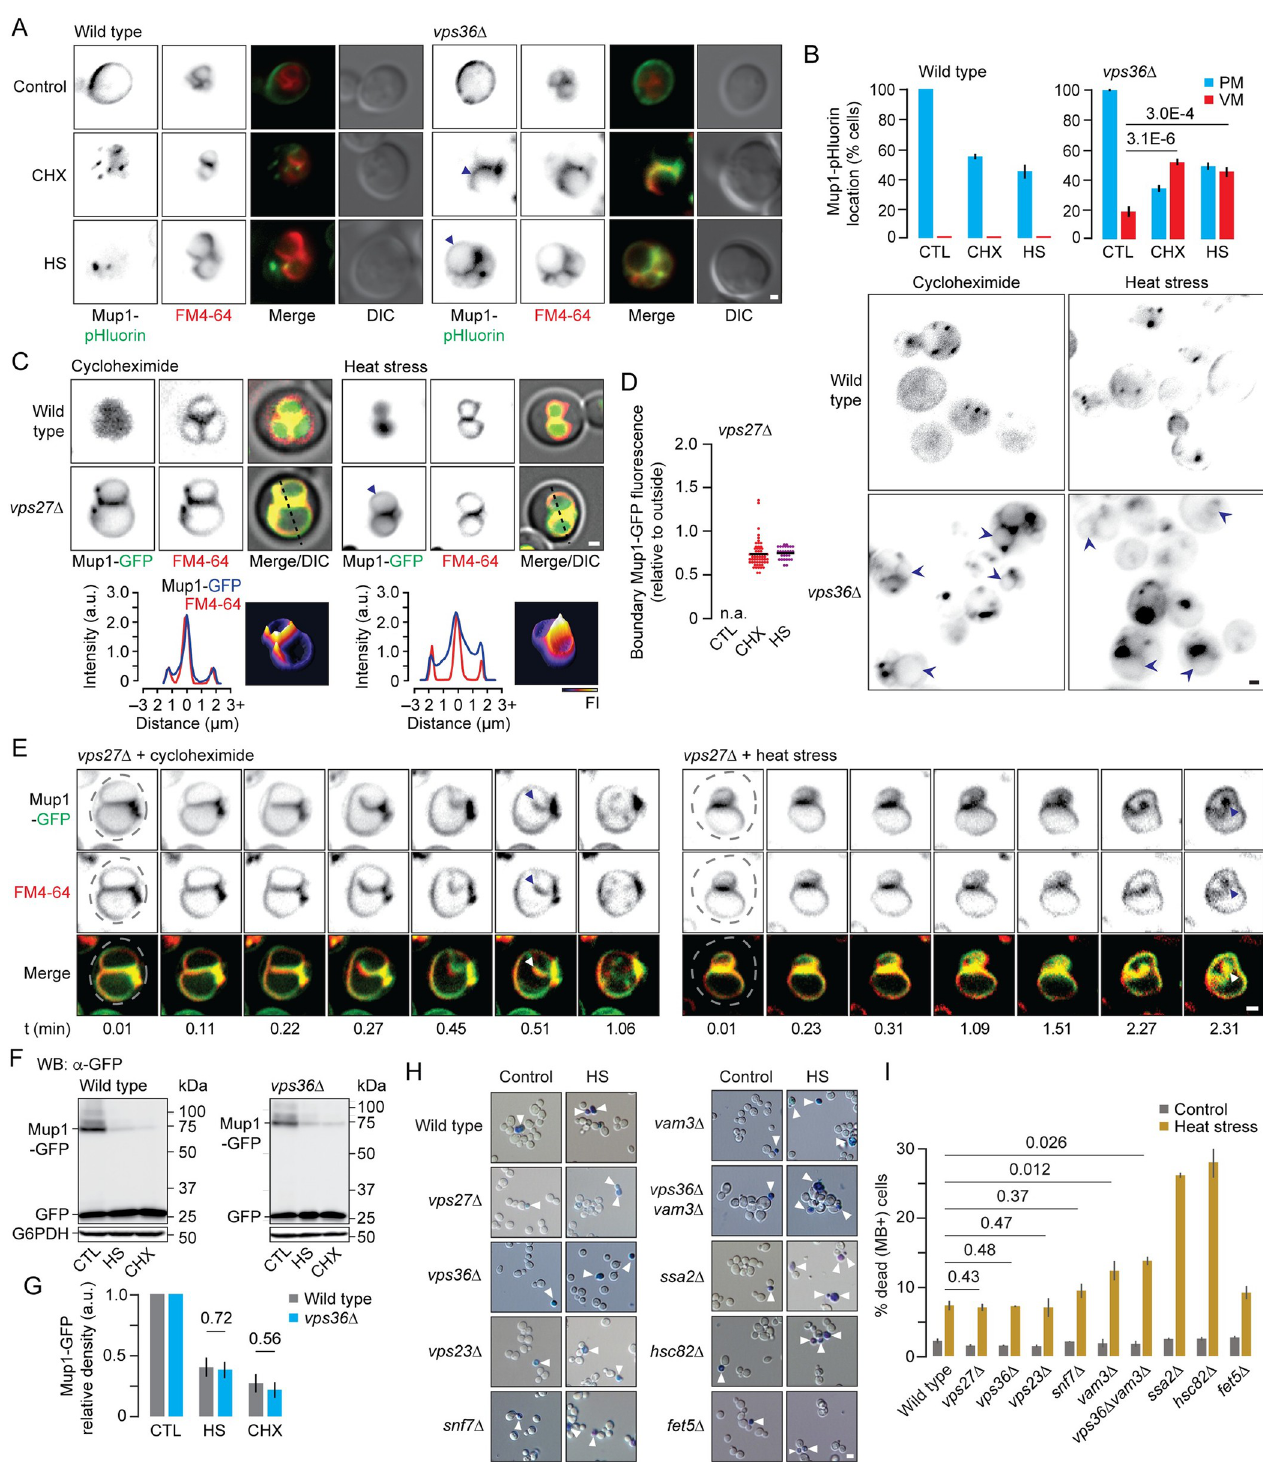
Fig 4. The ILF pathway degrades Mup1 in response to heat stress or cycloheximide in cells missing ESCRTs. (A) Fluorescence and DIC micrographs of live wild type or vps36 Δ cells stained with FM4-64 expressing Mup1-pHluorin before (control) or after addition of 100 μ M cycloheximide (CHX) or heat stress (HS; 42˚C for 15 minutes). Arrowheads indicate Mup1-pHluorin on vacuole membranes. (B) Proportion of wild type or vps36 Δ cells showing Mup1-pHluorin fluorescence on the plasma membrane (PM) or vacuole membranes (VM) before or after treatment with cycloheximide (CHX) or heat stress (HS). (below) Micrographs show Mup1-pHluorin location within cells; arrowheads indicate vacuole membranes. Number of cells analyzed (control, HS, CHX) are: WT (318,